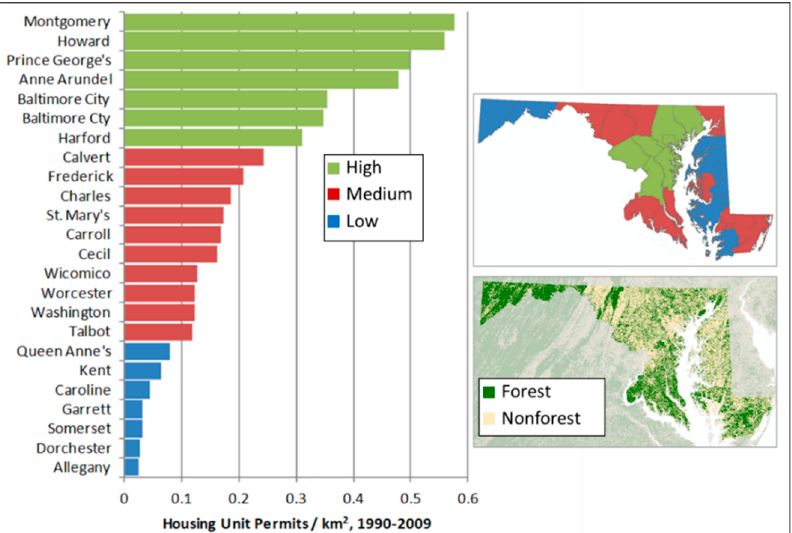
Figure 5. Subpopulations of counties created based on a grouping algorithm and housing unit permit information. PAI was calculated for each subpopulation (low, medium, and high housing permit density) for 2 periods and multiple separation distances. Locations of county groups and forest / nonforest map from NLCD 2011 are shown for